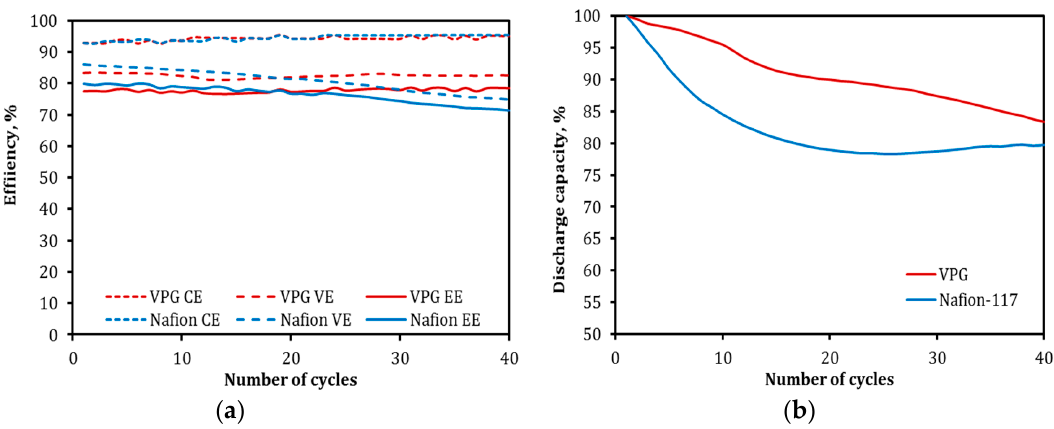
Figure 14. Comparison of cyclic operation between VPG-VRFB and Nafion-VRFB: ( a ) CE, VE, and EE and ( b ) discharge capacity